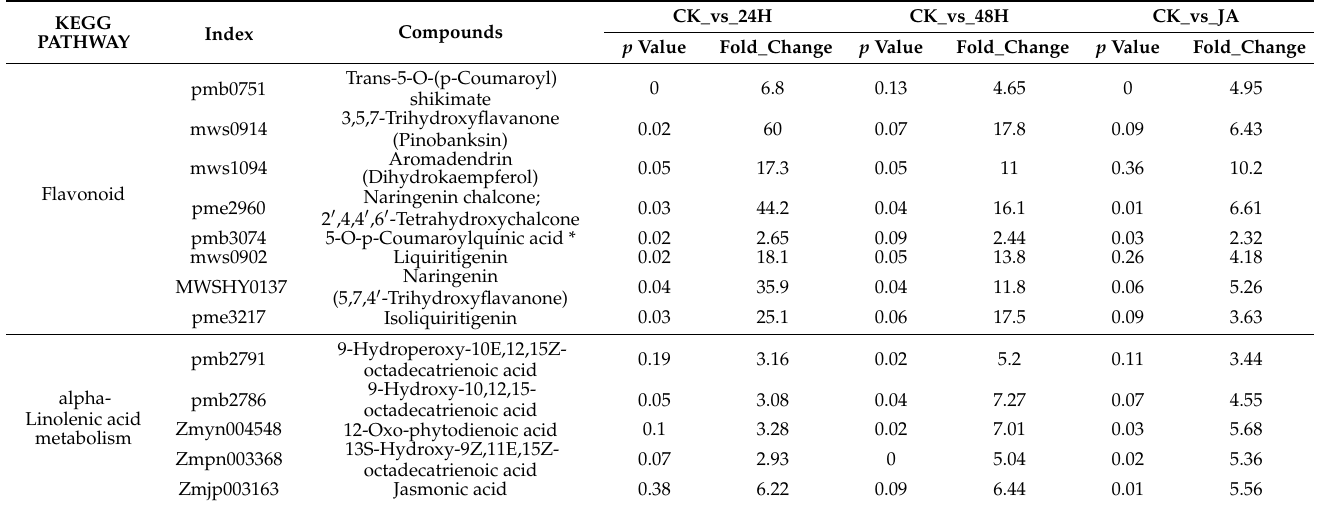
Table 4. Overlapping differentially expressed metabolites related to flavonoid biosynthesis and alpha-linolenic acid metabolism detected in different